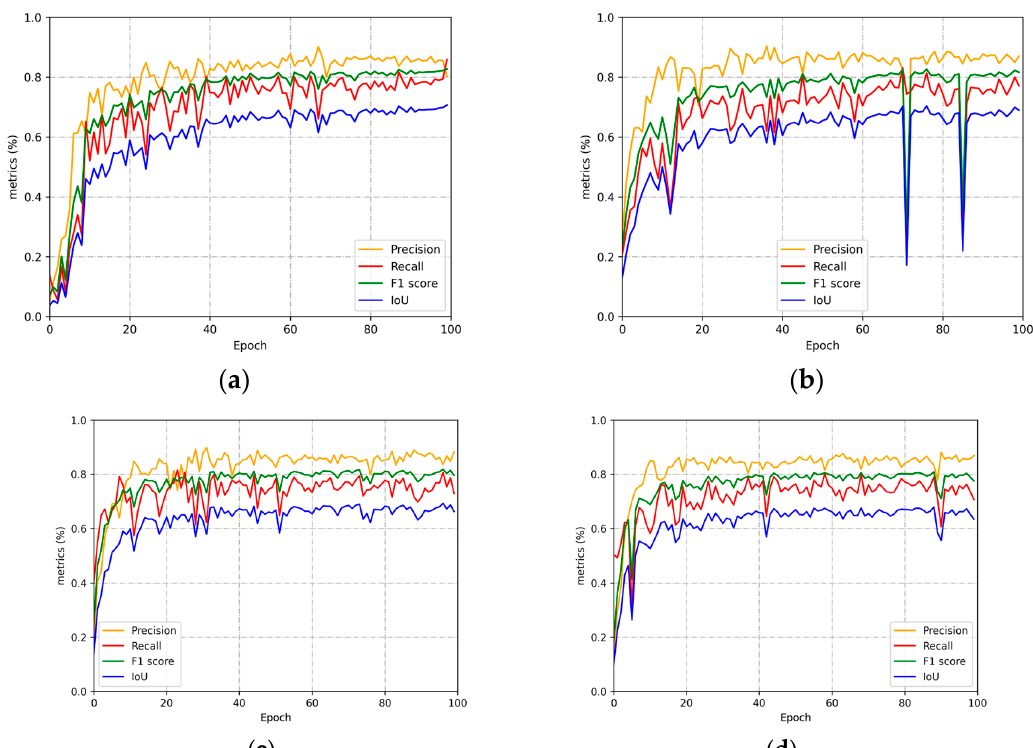
Figure 5. The metrics Precision, Recall, IoU, and F1 score as obtained from Linknet for different backbones: ( a ) vgg16, ( b ) resnet152, ( c ) densenet201, ( d ) inceptionv3.